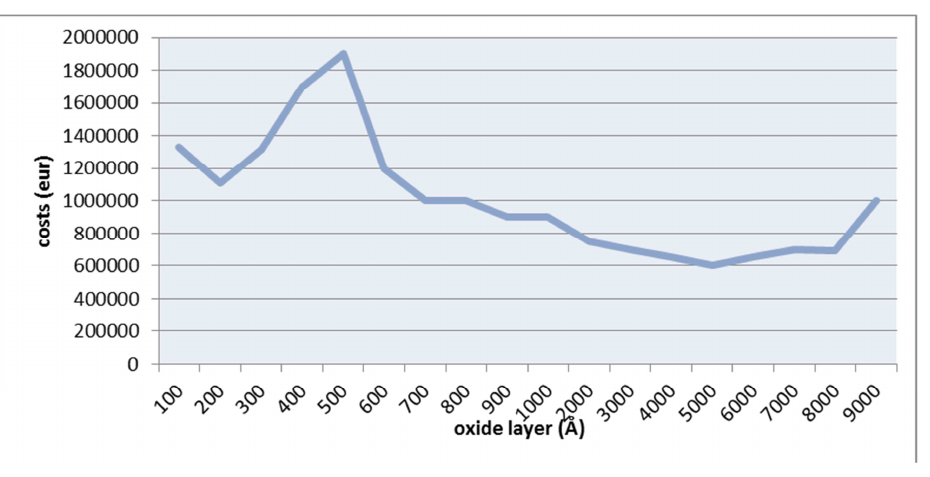
Figure 4 – Investment costs of technology (Source: own